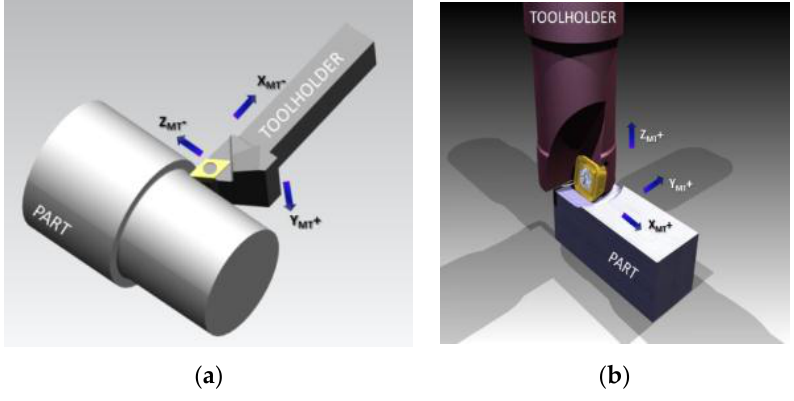
Figure 6. Orientation of a modal vector: ( a ) Turning operation; ( b ) Milling operation.